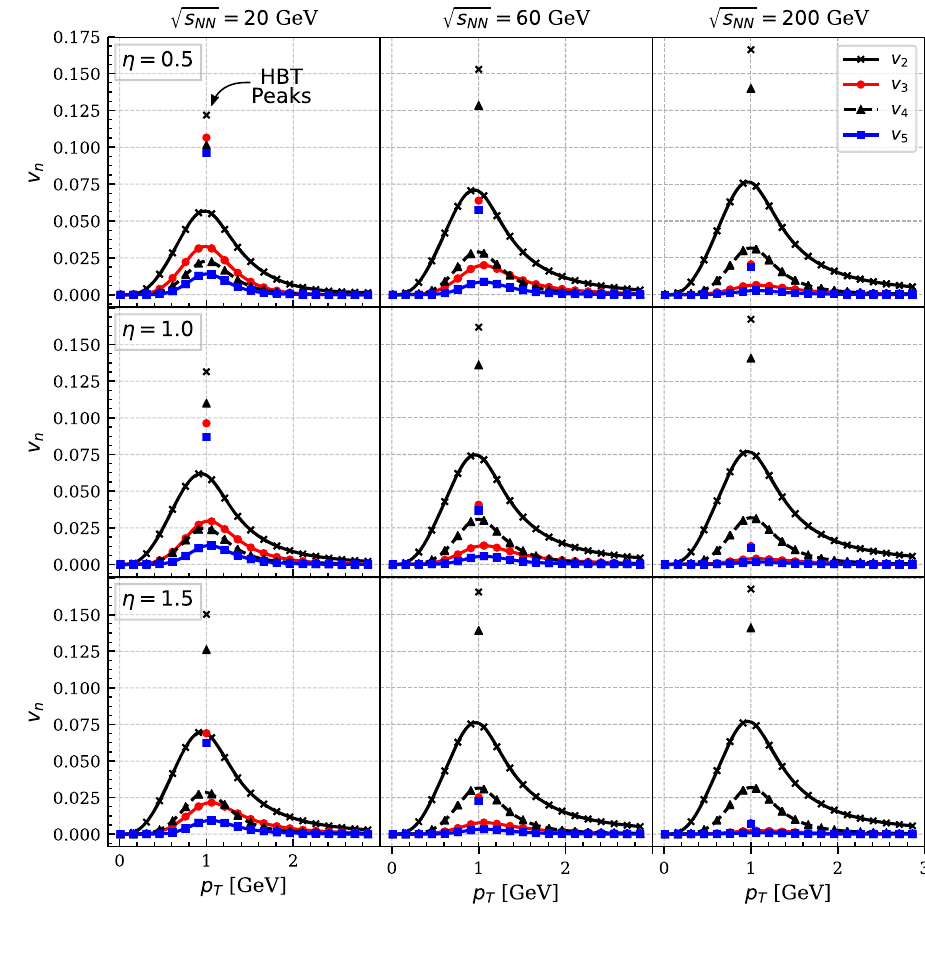
√ = 1 GeV, s NN = 20 GeV and η 1 = η 2 = 1 . 5 T